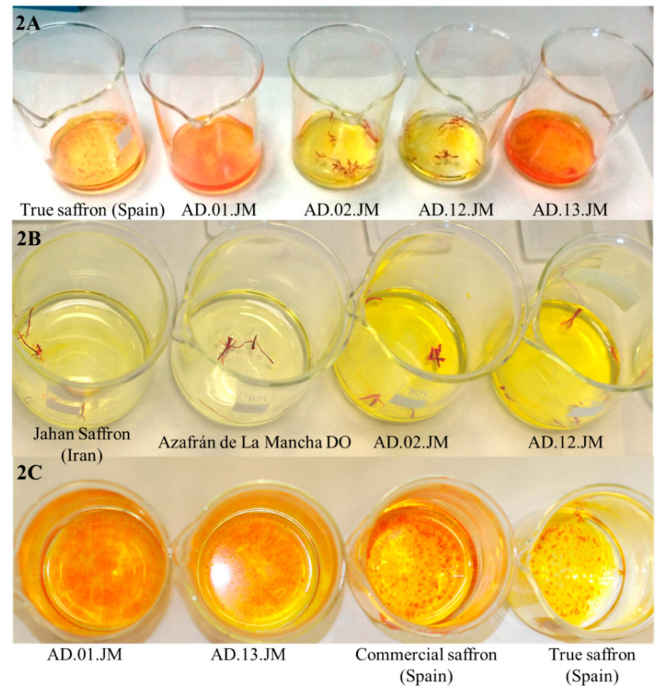
Figure 2. Comparison of the different coloring properties of true and adulterated saffron samples. ( A ) Different staining capacity of the same amount of true saffron powder (true saffron from